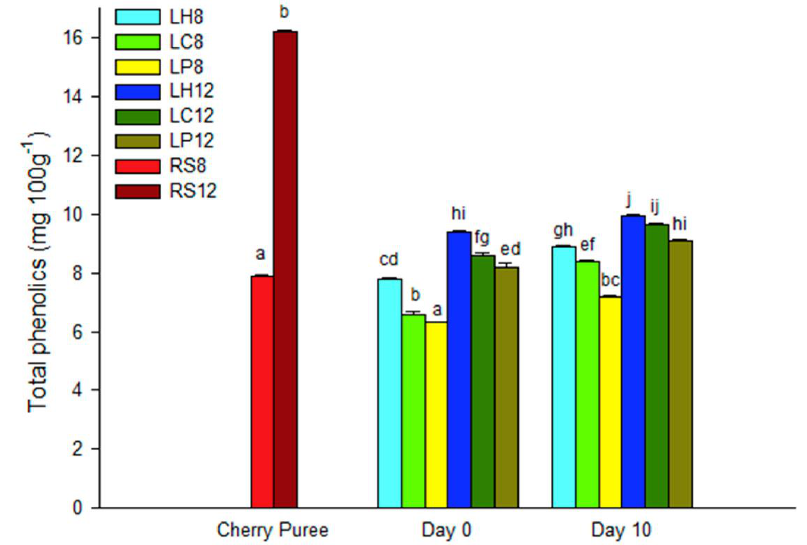
Figure 1. Concentration of total phenols (mg 100 g −1 ) of sweet cherry puree before incorporation [RS8: